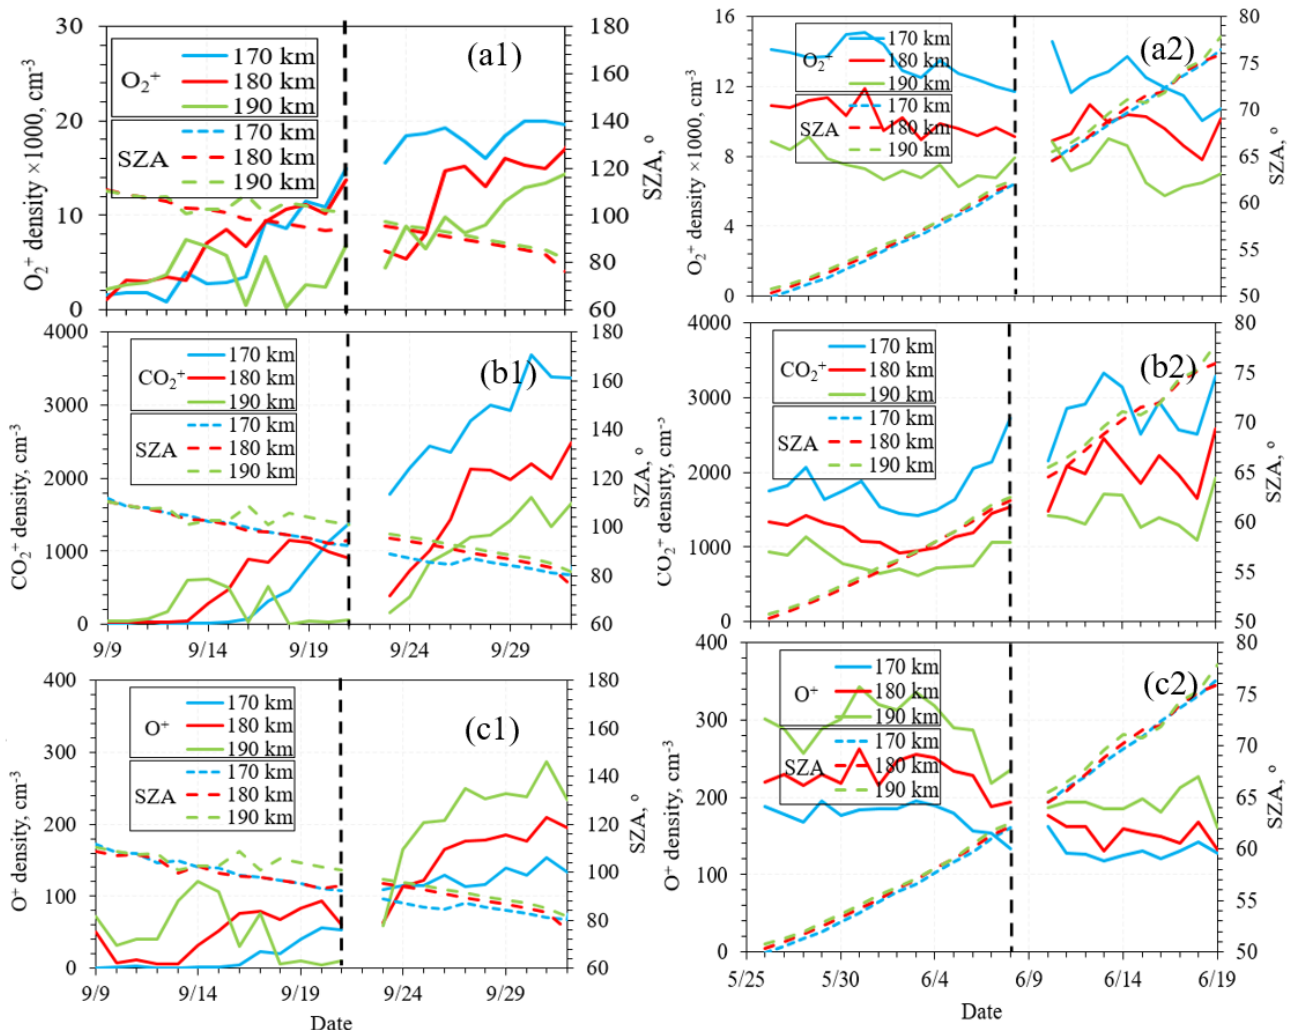
Figure 4. O + , CO 2+ , and O 2+ densities (cm − 3 ) and solar zenith angle variation (colored solid and dashed lines respectively) at 170 km; 180 km; and 190 km from 9 September–4 October 2016 ( a1 – c1 ) and 27 May–17 June 2018 ( a2 – c2 ). The dashed vertical black line marks the beginning of the 2016 regional dust storm on 20 September ( a1 – c1 ) and the beginning of the 2018 global dust storm on 8 June ( a2 – c2 ). Right axis: species density; left axis: SZA.